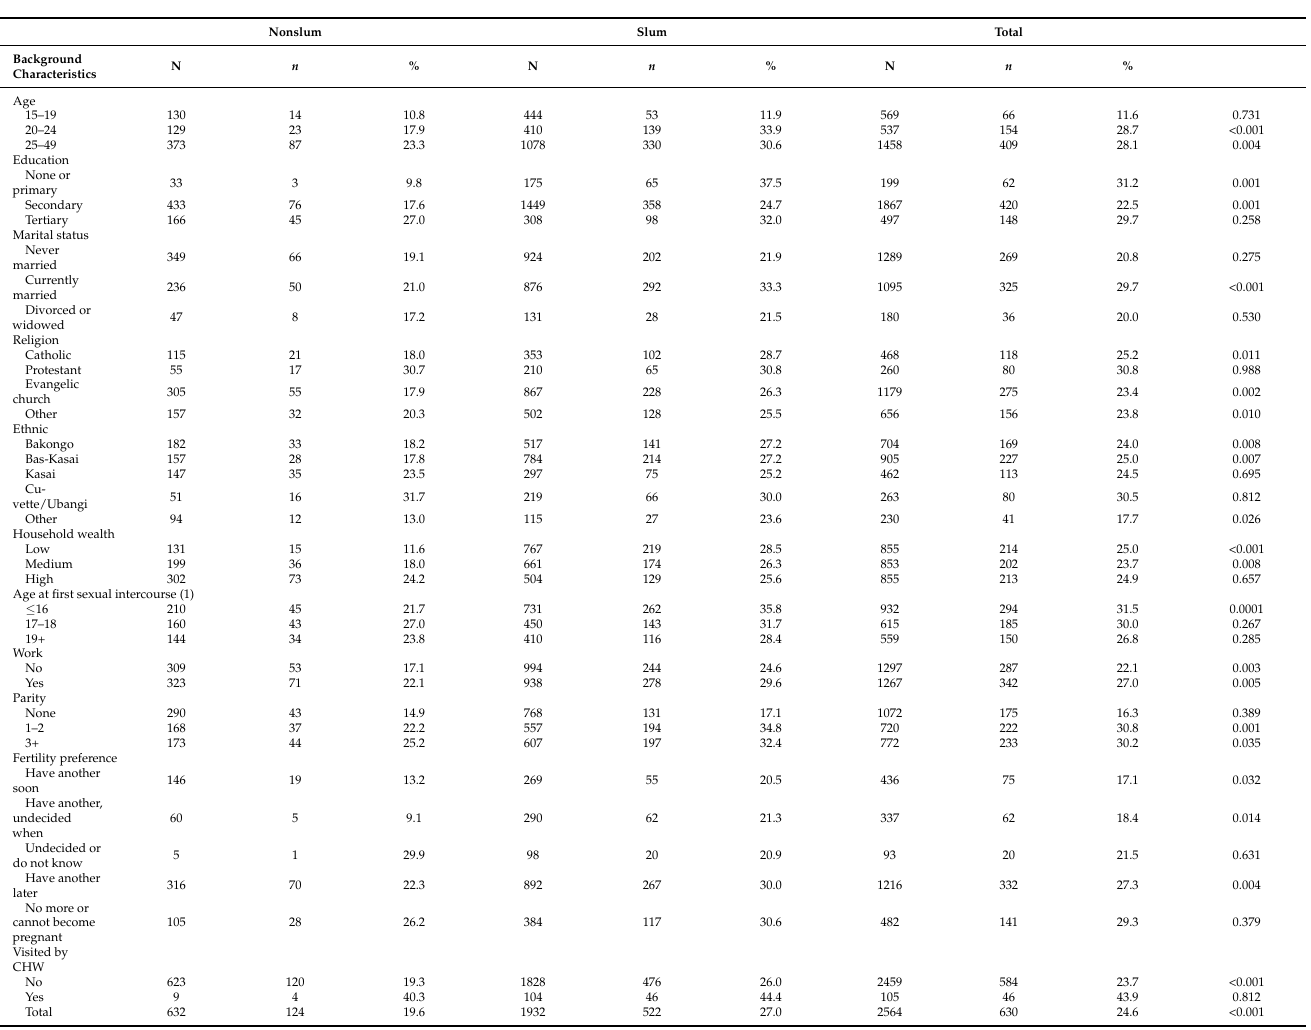
Table 2. Modern contraceptive prevalence among women aged 15–49 in Kinshasa by background characteristics and type of neighborhood, 2020.